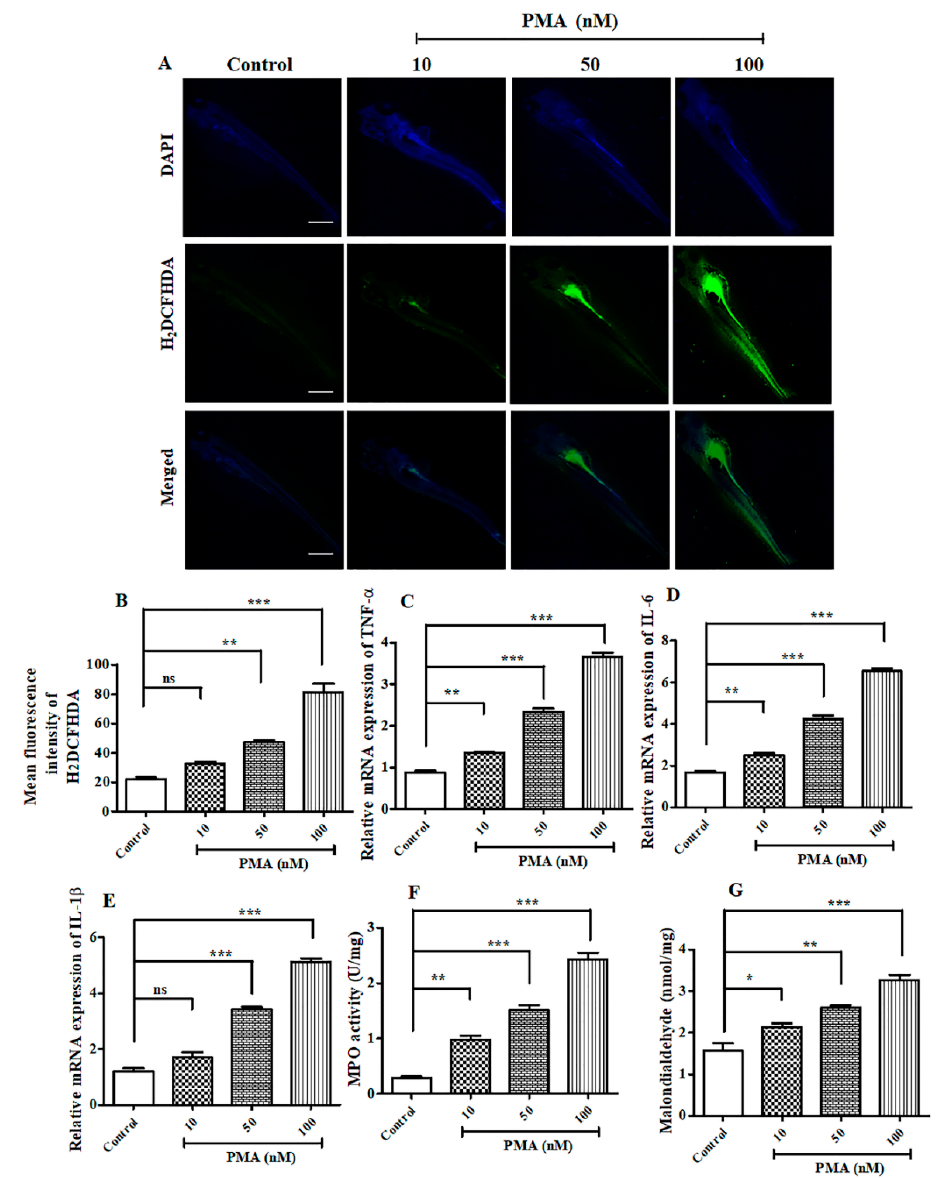
Figure 4. PMA induced elevated reactive oxygen species (ROS) and inflammatory response in Zebrafish larvae. ( A ) H 2 DCFDA staining on Zebrafish larvae after PMA treatment on 6 dpf larvae, scale bar = 200 μ M at 4× magnification ( B ) Mean fluorescence intensity of H 2 DCFDA, ( C ) Relative